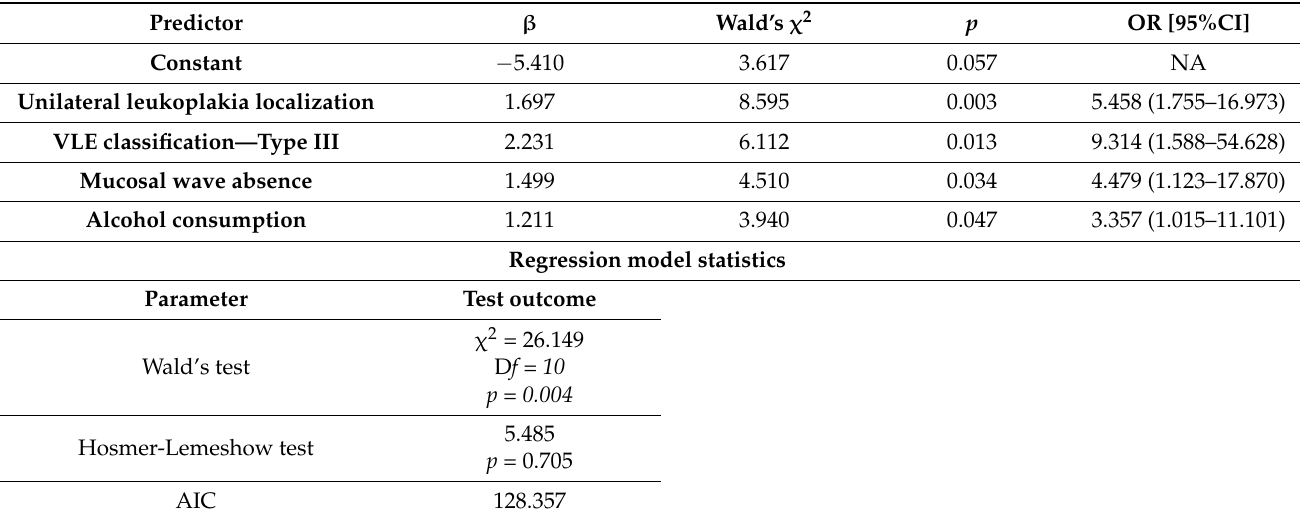
Table 5. Summary of multivariate analysis using logistic regression, including the parameters for the regression model and the goodness-of-fit test results.